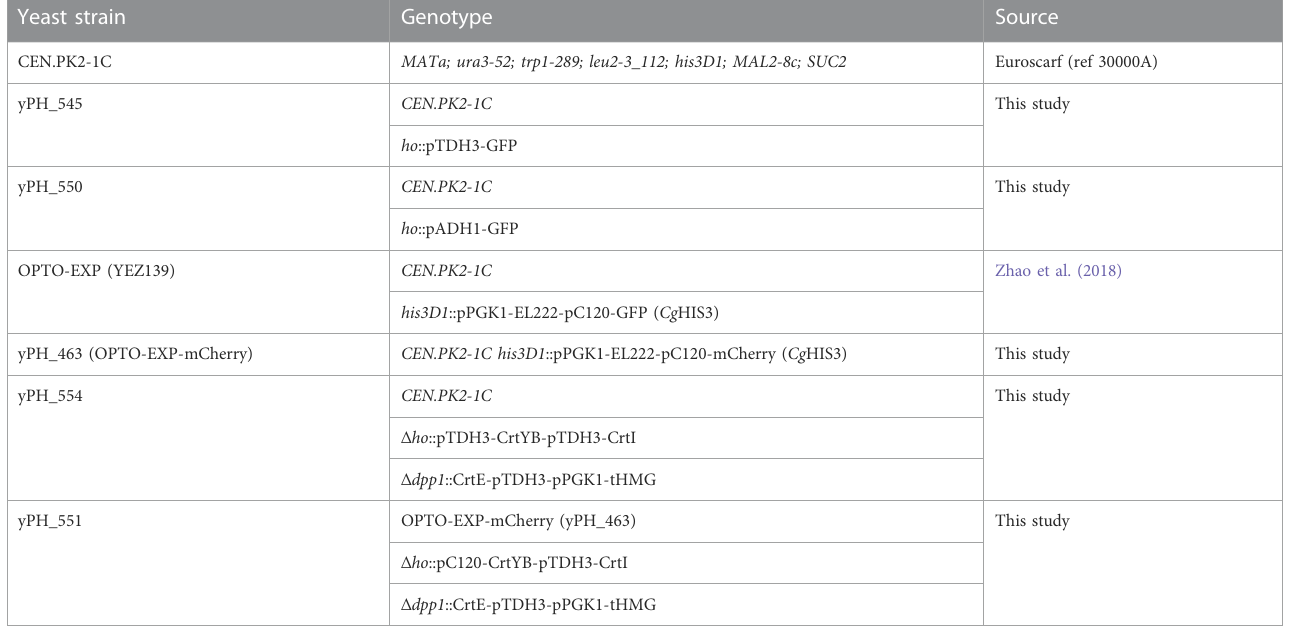
TABLE 2 Strains used in this study